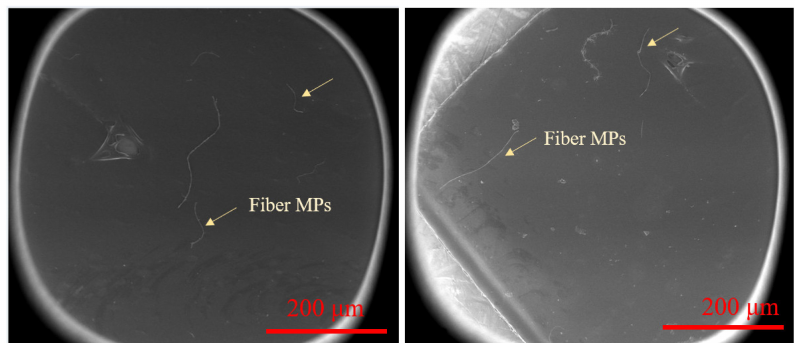
Figure 1. SEM images of fiber MPs on the inner surface of TOFCs.